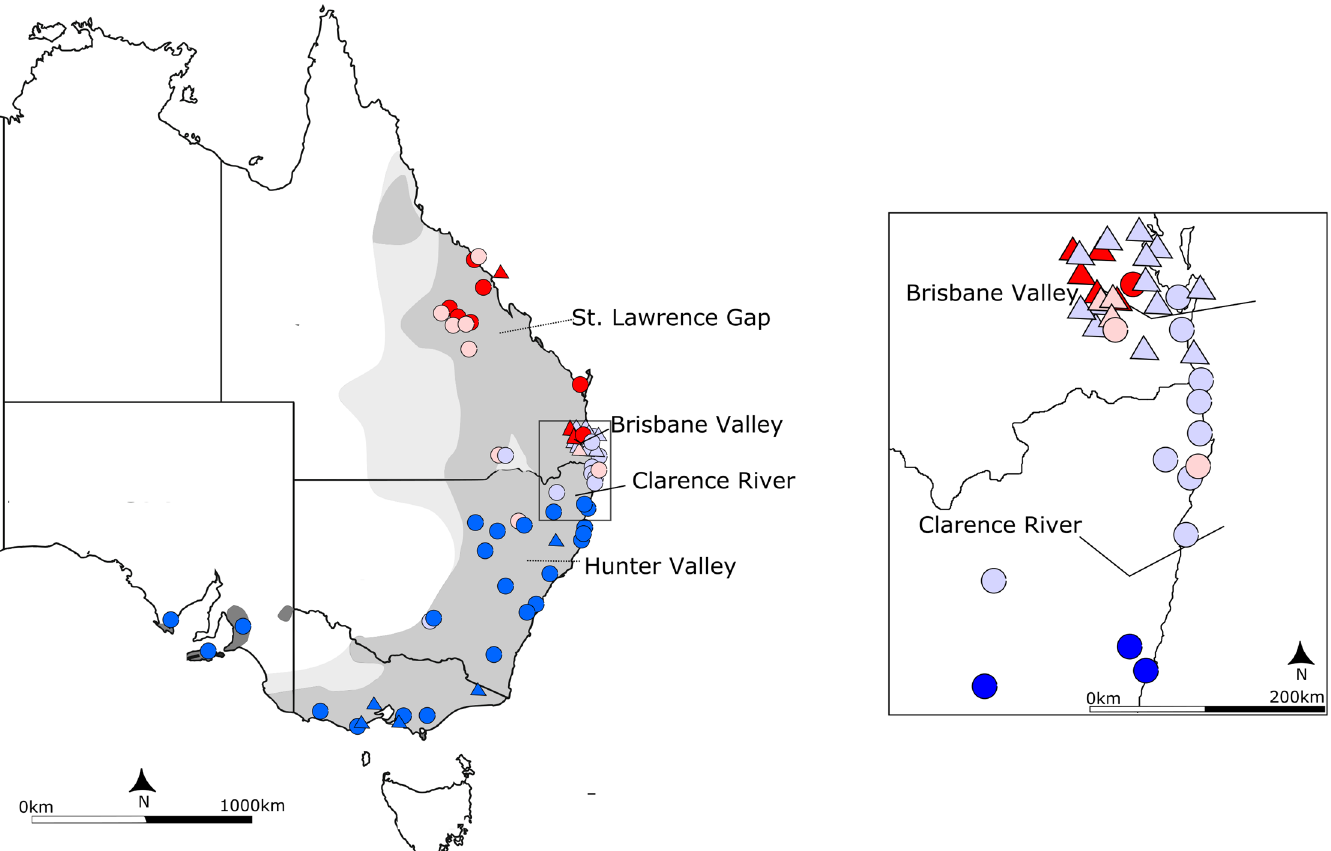
Fig 3. Geographical distribution of the koala, Phascolarctos cinereus , showing the locations of sampled mitochondrial DNA Control Region lineages. The current distribution is shown in grey, with the historical range in light grey and introduced populations in dark grey. Sampling locations for this study are shown as circles with triangles representing sites only sampled by previous studies. The identified mitochondrial DNA Control Region lineages are represented by colours (northern lineage 1: red; northern lineage 2: light red; central lineage: purple; southern lineage: blue). Biogeographic barriers that appear to have impacted on koalas, Brisbane Valley (BVB) and Clarence River (CRB) are shown as solid lines; other putative barriers are shown as dashed lines (St. Lawrence Gap and Hunter Valley). The inset shows the distribution of sampled haplotypes around the two proposed biogeographic barriers, BVB and